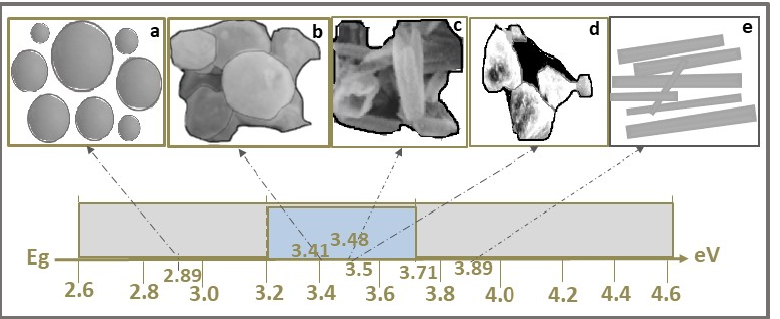
Figure 1. ZnS band gap energy values and their variation with ZnS NPs’ morphologies: spheres ( a ), nanosheets ( b ), nanotubes ( c ), random ( d ), and rod-shape ( e ).